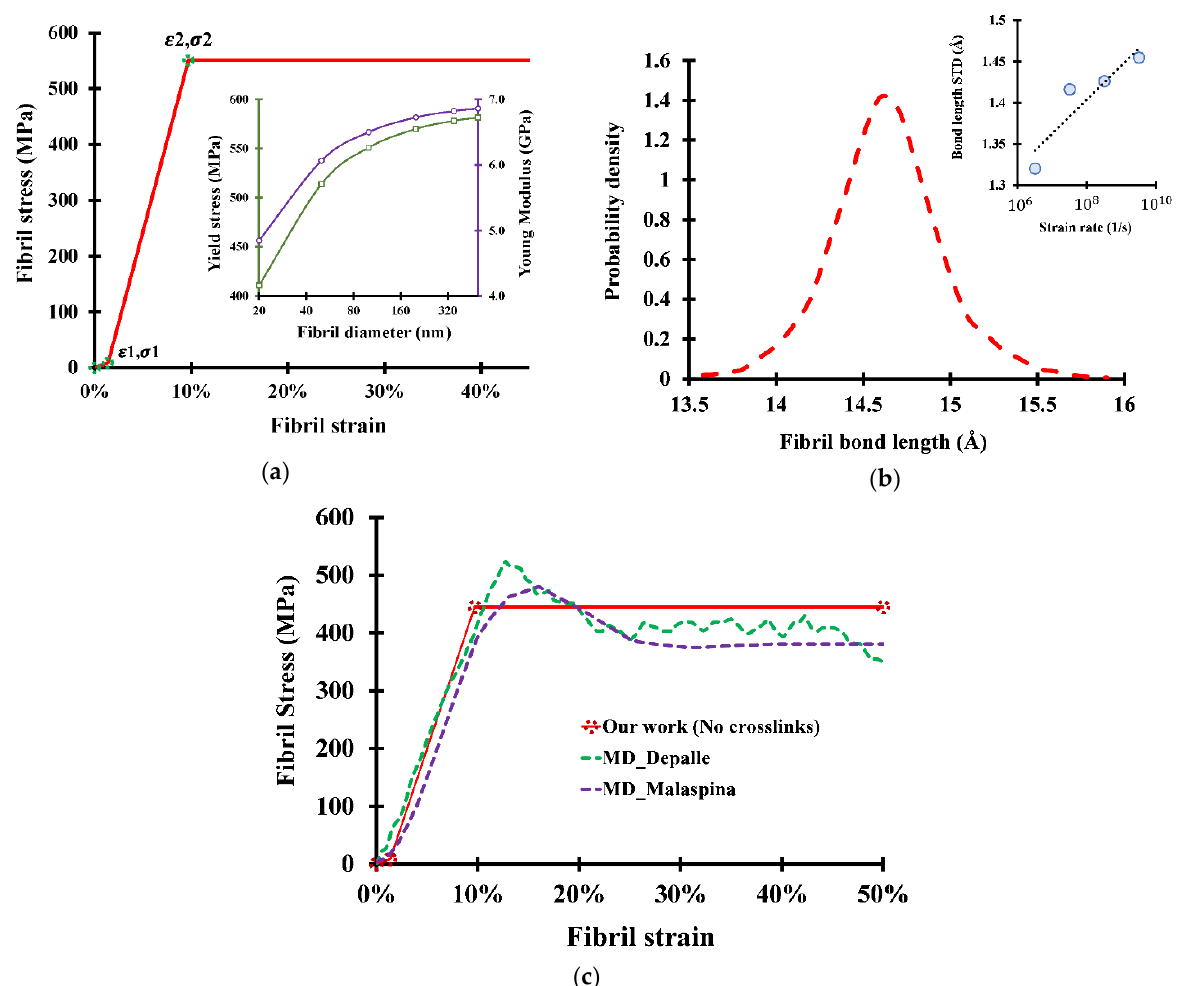
Figure 6. Non-crosslinked collagen fibril response to tensile load: ( a ) analytical stress–strain curve for a non-crosslinked collagen fibril with diameter φ = 100 nm; ( b ) bond length distribution for tropocollagen fibril (snapshot at a strain of 5.7%); ( c ) comparison of analytically derived stress–strain curve for a non-crosslinked collagen fibril with diameter φ = 25 nm and previous MD studies (Depalle et al., [18] and Malaspina et al., [27]).